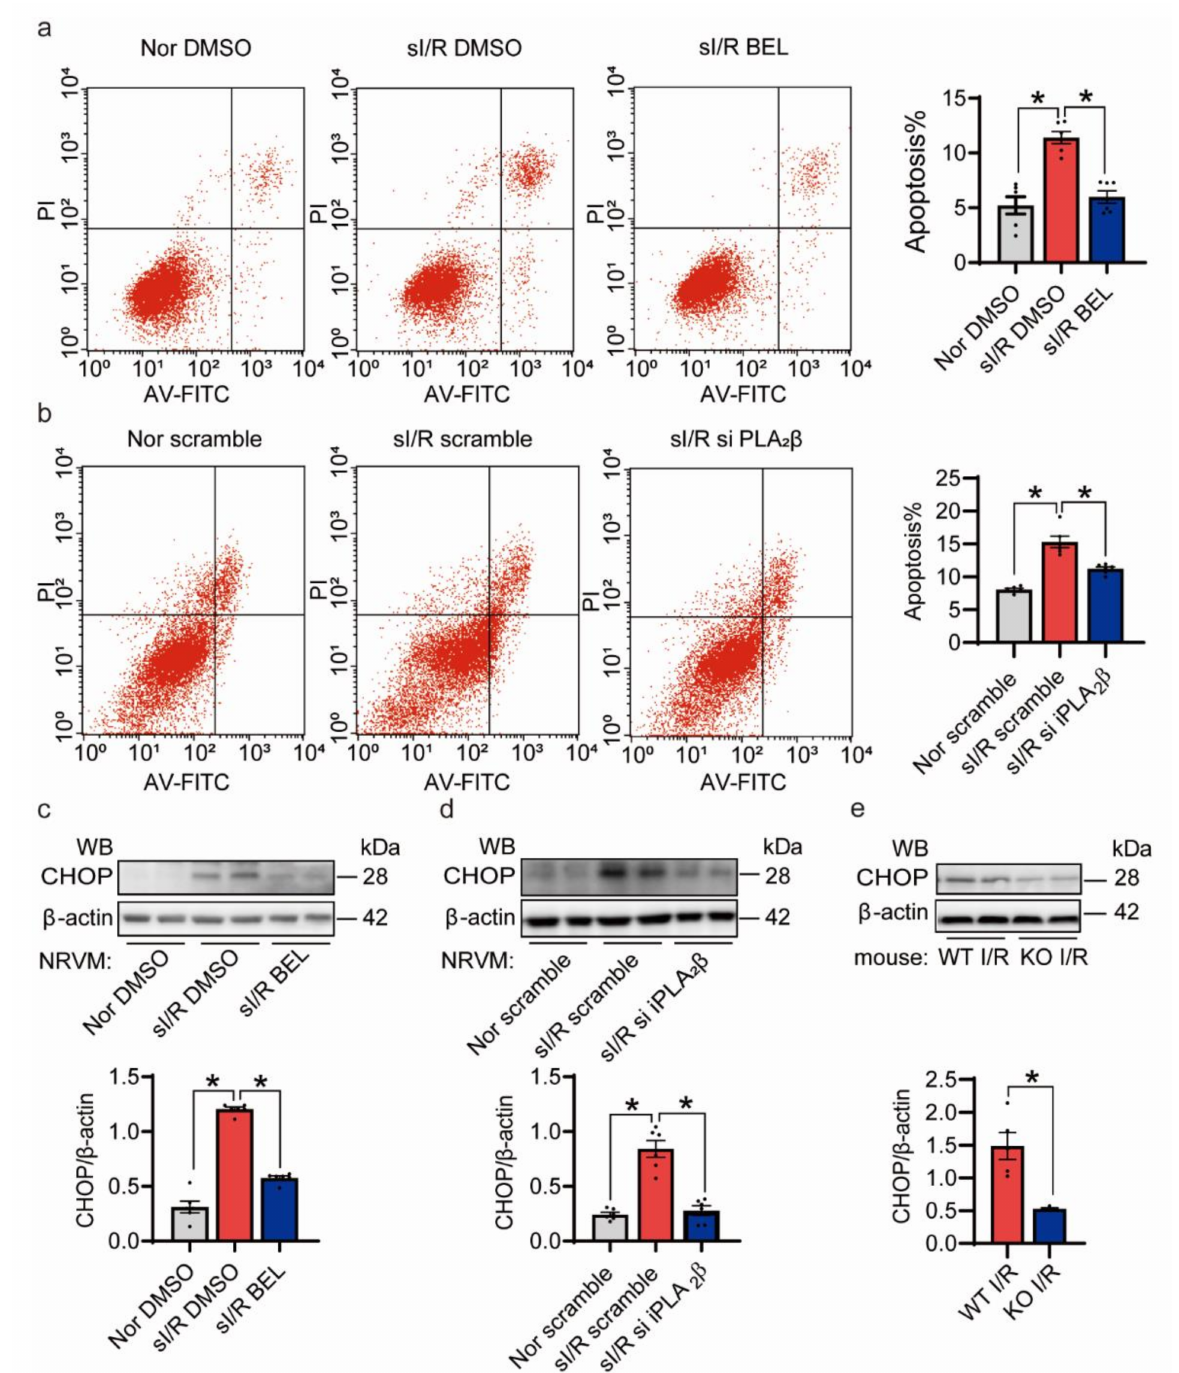
Figure 5. Inhibition of iPLA 2 β alleviates I/R injury by reducing apoptosis. ( a ) Suppression of iPLA 2 β by BEL conferred significant protection against I/R-induced cell death as determined by flow cytometry of Annexin V- and PI-positive cells. A representative histogram is shown. Quantification is shown on the right. n = 6 per group. ( b ) Knockdown of iPLA 2 β protected NRVMs against I/R-induced cell death as determined by flow cytometry of Annexin V- and PI-positive cells. A representative histogram is shown. Quantification is shown on the right. n = 6 per group. ( c ) The expression of CHOP was detected and quantified by Western blotting. n = 6 per group. ( d ) The expression of CHOP was reduced by transfection with siiPLA 2 β . n = 6 per group. ( e ) CHOP expression in the iPLA 2 β -KO mouse heart was reduced upon I/R injury. β -actin was used as a loading control. n = 5 per group. Data are represented as mean ± SEM. All experiments were independently replicated in triplicate. * p <